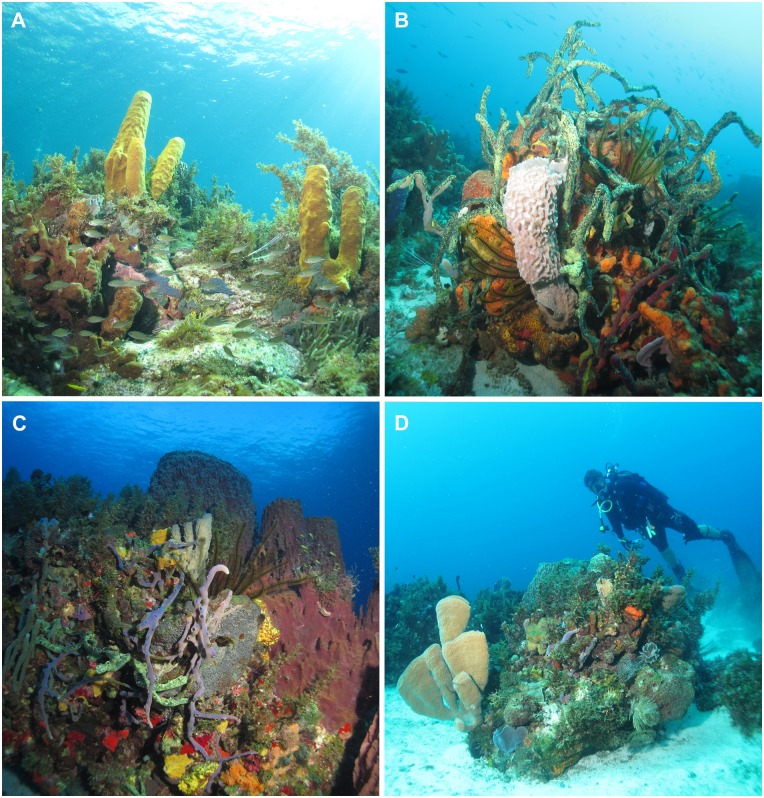
In situ photographs of reef and rocky bottoms in Martinique.A) Shallow rocky habitat where tubes of yellow Aplysina fistularis, large solid Agelas species, and patches of Halisarca caerulea mingle between the Sargassum sp. algae and the coral rubble. B) Massive sponge aggregations with at least six large sponge species (one large tube of Callyspongia plicifera, clumps of Iotrochota birotulata, Agelas spp., Aiolochroia crassa, Myrmekioderma rea, Amphimedon compressa), and stalk crinoids. C) The largest reef sponges the barrel sponge Xestospongia muta aggregates a large diversity of erect and repent species of Callyspongia, Niphates, Amphimedon and Iotrochota, massive Aiolochroia and Mycale, and thin crusts of Spirastrella. D) Extremely large tube clumps of Callyspongia plicifera reside among the varied set of tubular, rods, and massive shaped sponges that aggregate with polychaete worms, algae, and crinoids. All pictures by T. Pérez.